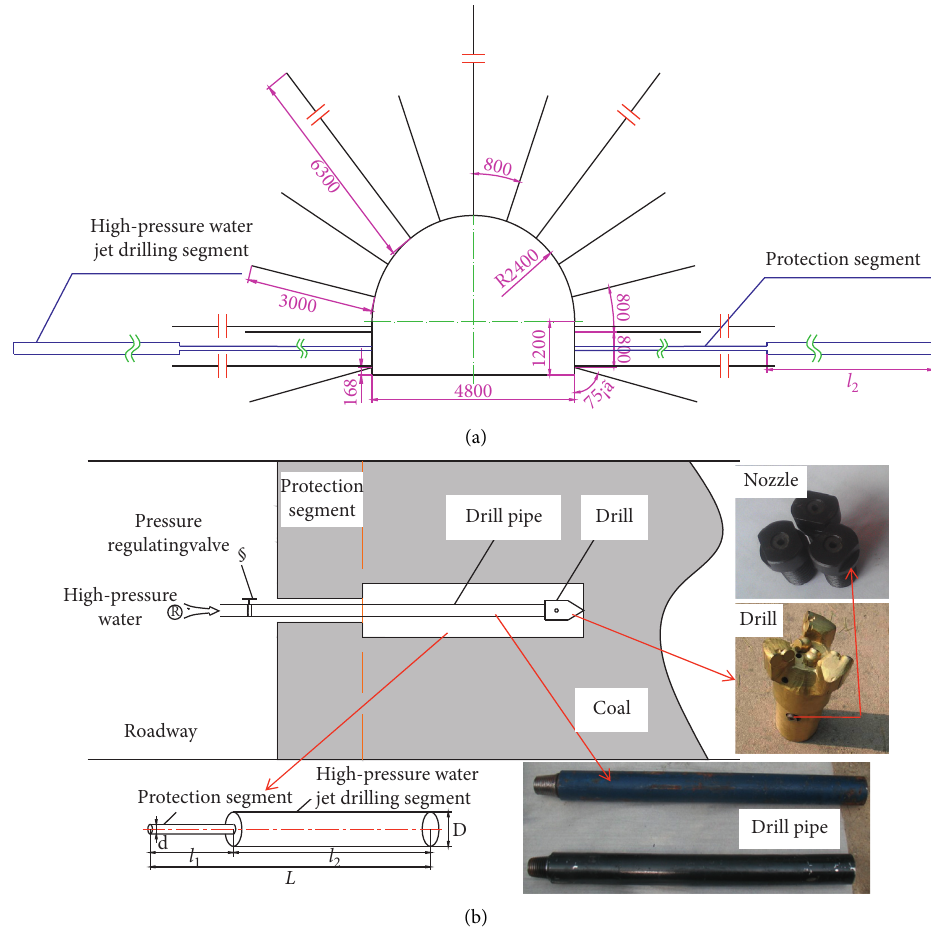
Figure 12: Synergistic effect of prevention rock burst: (a) after the high-pressure water jet roadway gang decompression on the basis of cooperative support; (b) schematic diagram of high-pressure water jet roadway gang